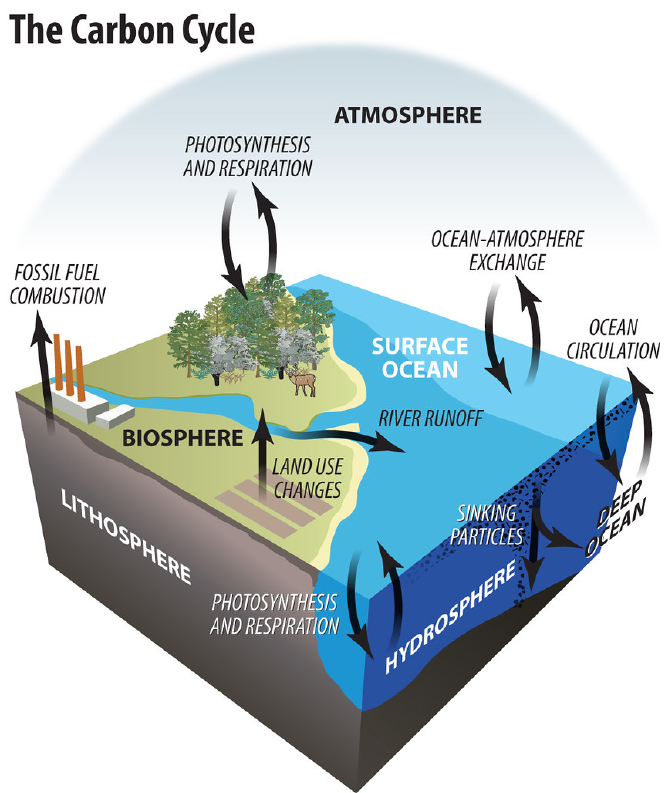
Figure 2. Typical stylized carbon cycle in an SCM. Source: Tim Meko on Flickr: https://www.flickr. com/photos/timmeko/6106058409/in/album-72157621811047263/, accessed on 15 December